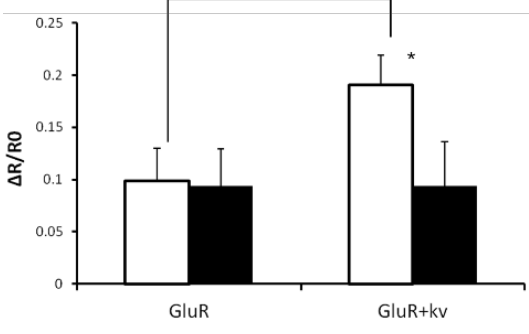
Figure 4. Ion flux level of post-synapse model cells that express only GluR or coexpress GluR and Kv1.3 (2 mM glutamate application [open]: 2 mM glutamate application after 10 nM margatoxin treatment [filled]). Ca 2+ influx was monitored by changes in fura-2 340/380 nm ratio (R) normalized to baseline (Δ R/R0). The data represent the mean ± SD with ( * ) indicating P <